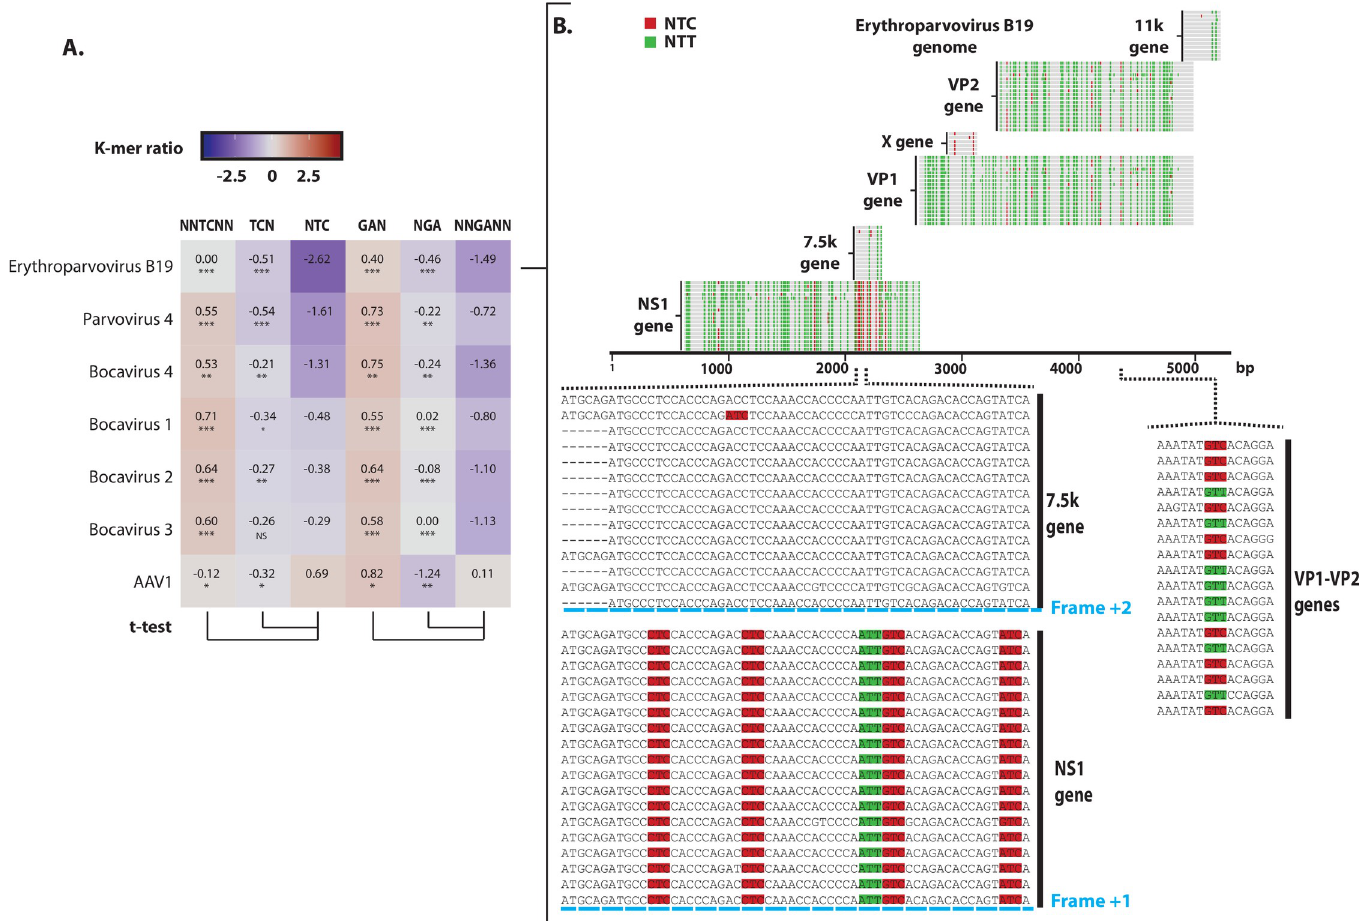
Fig 5. Intensive A3 footprint on both strands of the B19 Erythroparvovirus genome. A. The observed/expected ratios of TC dinucleotide at various codon positions for the B19 Erythroparvovirus were compared to those of the other human members of the parvoviridae family and depicted by a heatmap. A colored scale with increasing shades of blue indicating depletion and increasing shades of red indicating enrichment. P-values were calculated by Student’s unpaired, two-tailed t-test (NS for not significant, � p < 0.05, �� p < 0.01, ��� p < 0.001). B. Coding sequences (NS1, 7.5k, VP1, X, VP2 and 11k) from 18 full-length B19 erythroparvirus were depicted by grey lines overlaid by red marks to symbolize NTC and green marks to position NTT codons. Zoom-in detailed a 60 bp-long sequence from the NS1 and 7.5k genes (from nucleotide 1723 to 1783). A second zoom-in detailed a 15 bp-long sequence from the VP1-VP2 genes (from nucleotide 3973 to